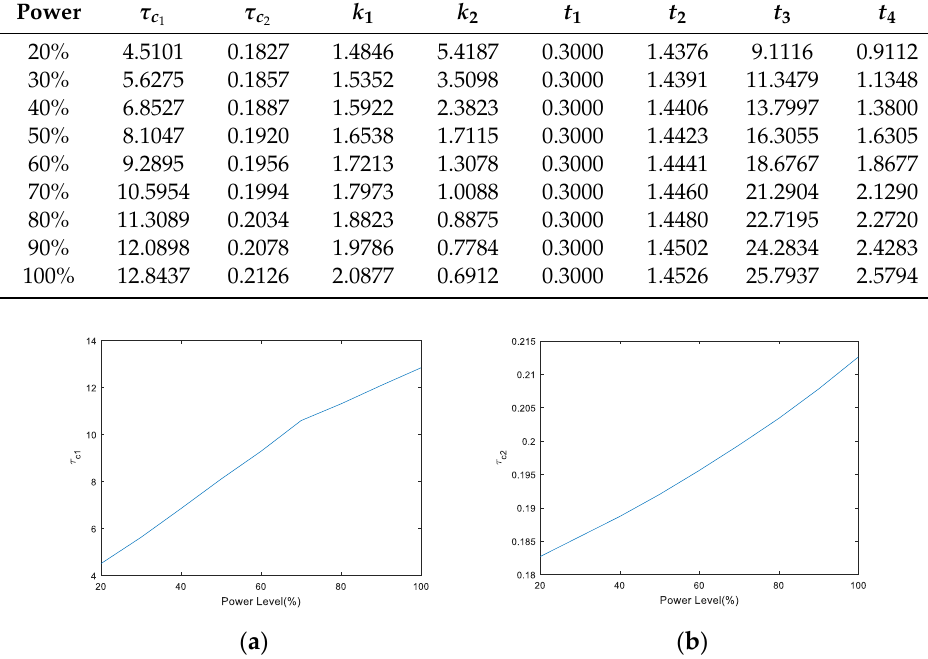
Table 2. Tuning parameters of water level control system.